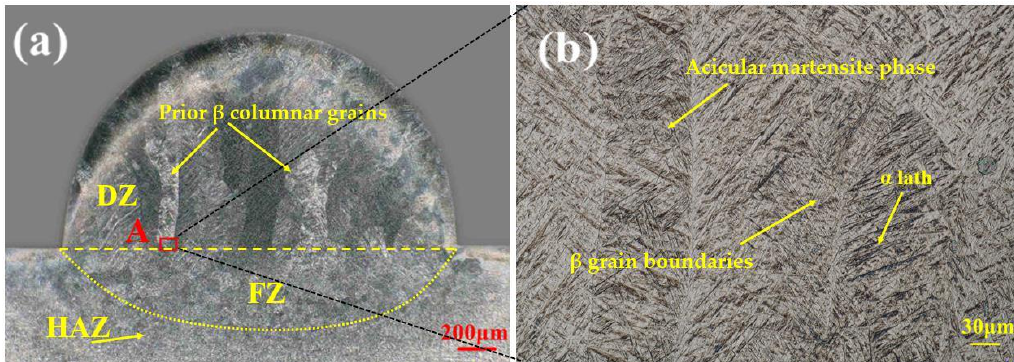
Figure 4. ( a ) The morphology of the cross-section of a typical etched single-bead Ti6Al4V sample, as shown by optical microscopy; ( b ) the area indicated in panel A.